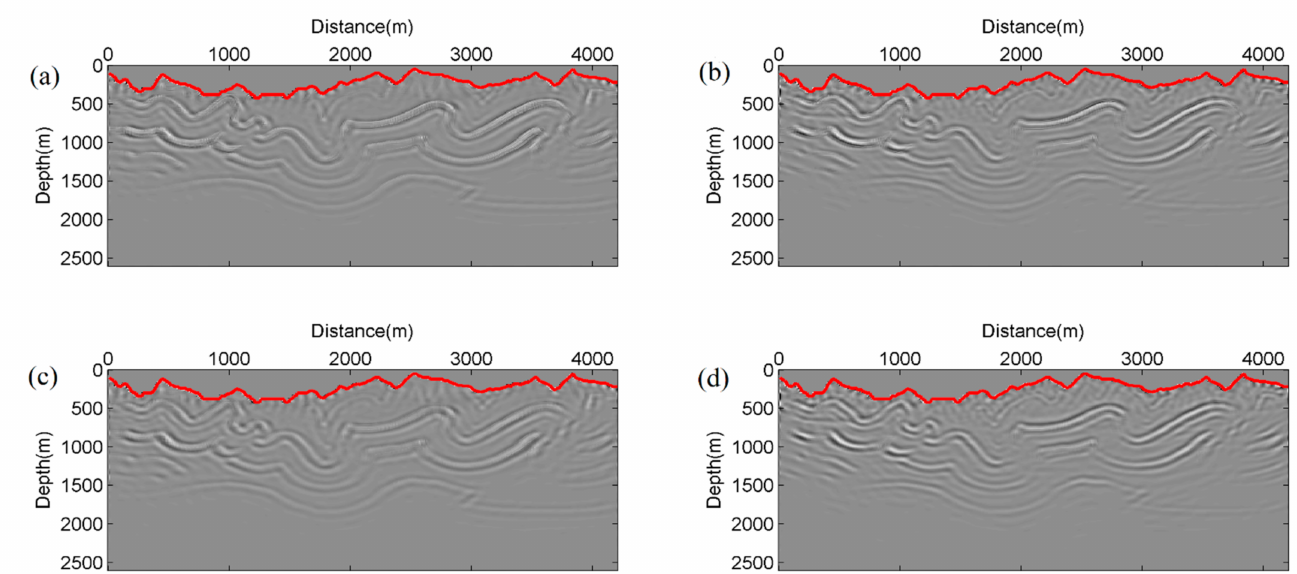
Figure 16. Migration images for modified-topography Canadian Foothills elastic models obtained using different migration models. The left panels are the PP-wave images, and the right panels are the PS-wave images. Incorrectly filled near- surface elastic parameters were also used. Panels ( a , b ) are the migration images with a 60 m × 60 m smoother migration model, and panels ( c , d ) are the migration images with a 100 m × 100 m smoother migration model. The red line is the surface